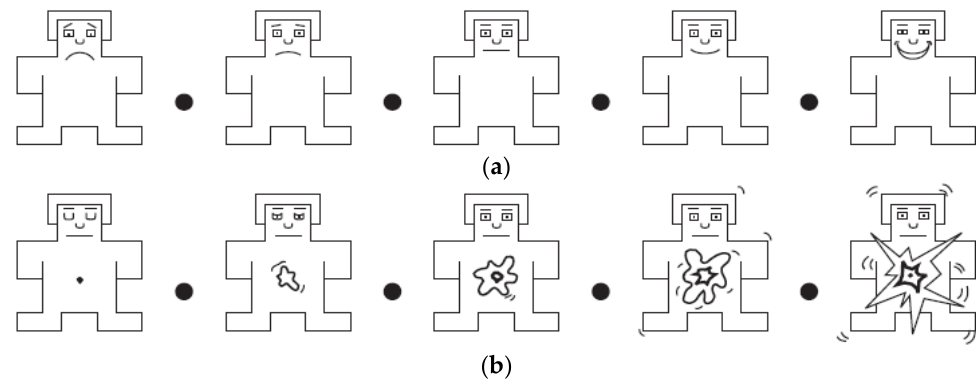
Figure 2. Images used for self-assessment manikins (SAM): ( a ) Valence SAM, ( b ) arousal SAM.